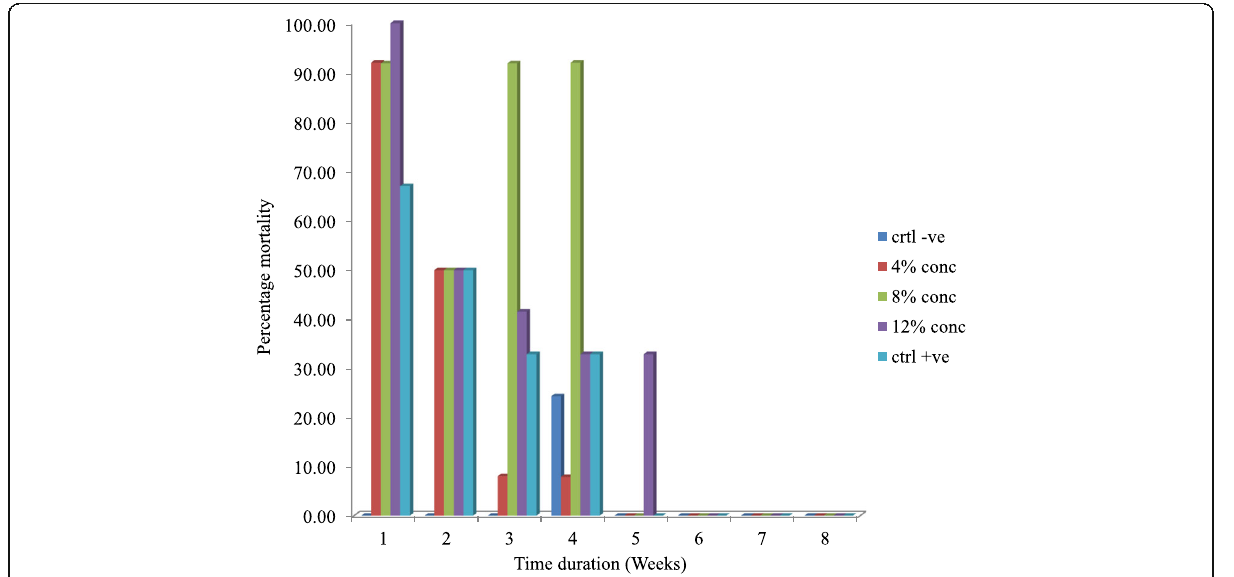
Fig. 1 Pesticidal effect of ethanolic extract of Piper